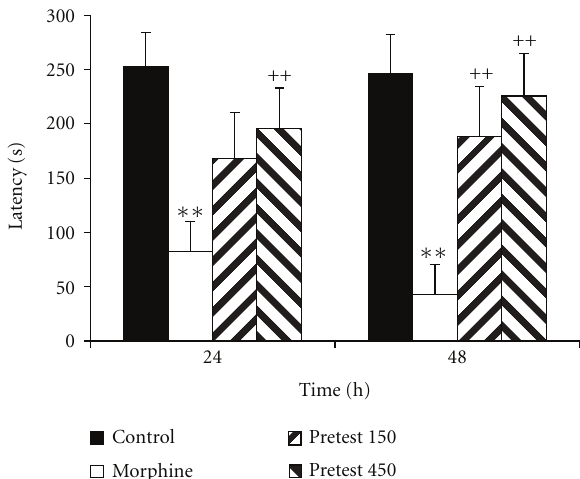
Figure 4: The e ff ects of pretest injection of sa ff ron extract on time latency for entering the dark compartment. The animals of the control group received saline instead of both sa ff ron extract and morphine. The animals of morphine group were treated by saline instead of SE but received morphine (5mg/kg, s.c.) 30 min before the training phase. Pretest 150 and pretest 450 groups were treated by 150 and 450 mg/kg of SE (i.p.), respectively, before the recall phase. The data were presented as mean ± SEM of the time latency (8 animals in each group). ∗∗ P < 0 . 01 compared with the control group and ++ P < 0 . 01 compared with the morphine group.